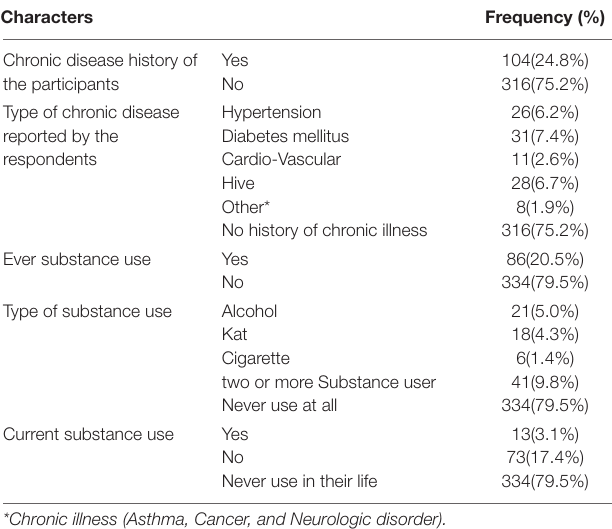
TABLE 1 | Socio-demographic characteristics of study participants among Dessie town prisoners in Dessie Amhara region, Northeast Ethiopia, October 2020; ( n = 420).